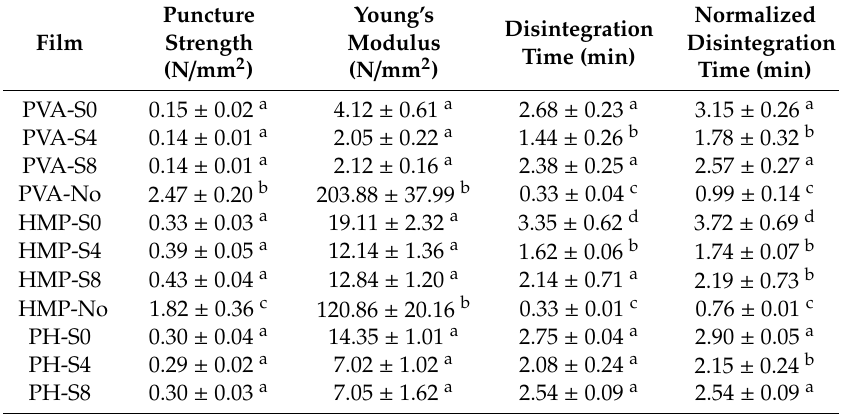
Table 4. Mechanical properties and disintegration time of phenytoin